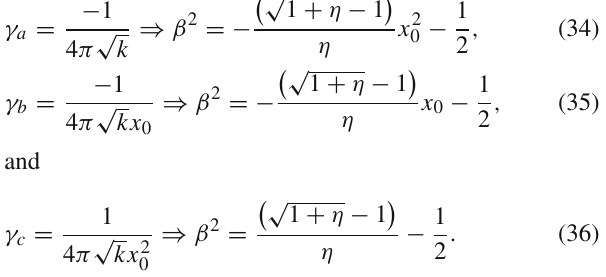
Figure 2 reflects the graphs for β 2 against x 0 for the three cases considered above. These figures show different fea- tures of stability in the vicinity of a 0 and beyond. The most important aspect is that there is always a range of values for β 2 for which the throat is stable, apart from any permitted values of k and η . As another important outcome, although for γ a and γ b in Eqs. (34) and (35) β 2 is permanently nega- tive in stable states, γ c in Eq. (36) makes it possible for β 2